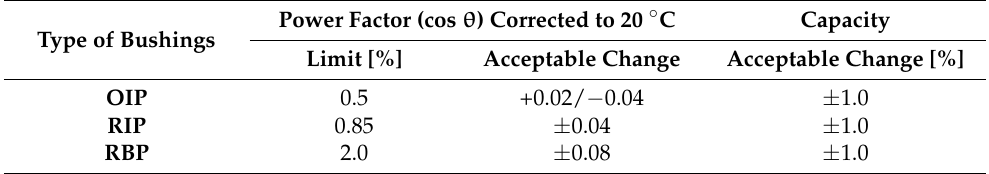
Table 16. Limits for power factor and capacity change in different types of crossing.